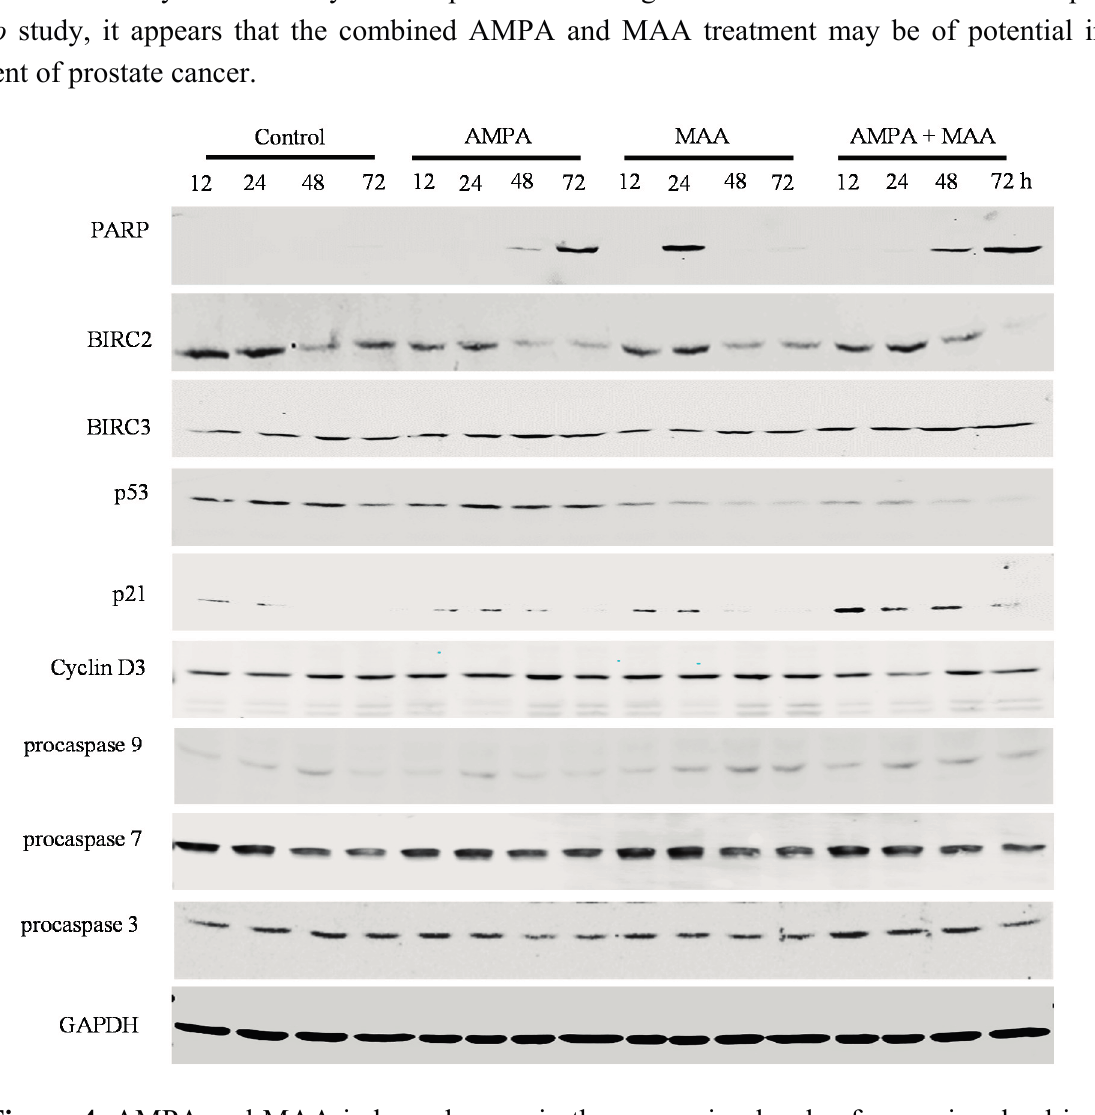
Figure 4. AMPA and MAA induce changes in the expression levels of genes involved in cell cycle arrest and apoptosis. LNCaP cells were exposed to 15 mM AMPA, 5 mM MAA or a combination of both AMPA and MAA for different time periods. The protein extracts were analyzed by Western blot to detect the indicated proteins. Glyceraldehyde 3-phosphate dehydrogenase (GAPDH) was probed as the loading